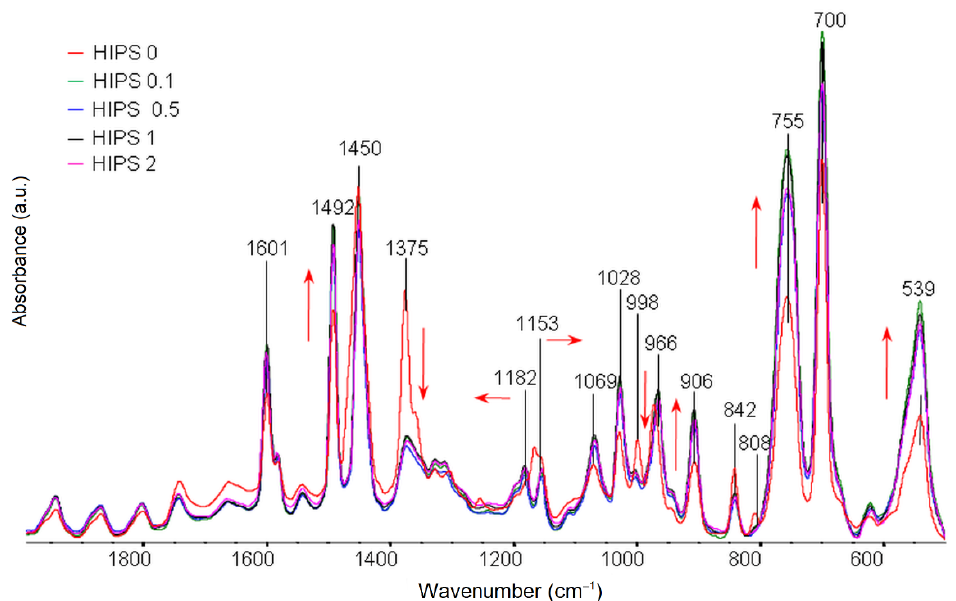
Figure 5. Summary of FTIR spectra for pure HIPS filaments and HIPS filaments with the addition of rGO in a range of 1975–500 cm − 1 . Table 2. Characteristic wavenumbers of the bands observed in the IR assignments for studied sam- ples [48].